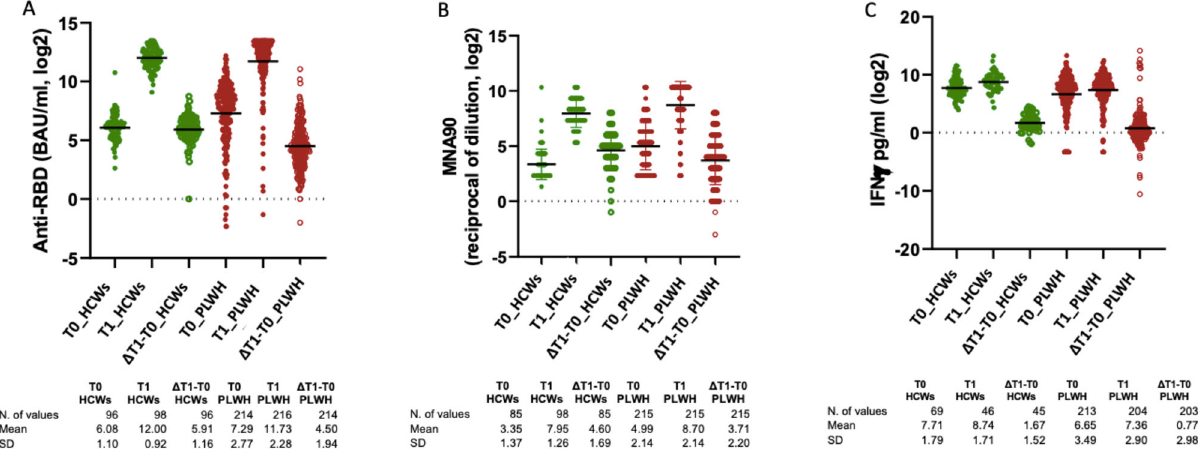
Fig. 3 | Changes of anti-RBD IgG, MNA 90 and IFN- γ from T0 to T1 in HCWs and PLWH. Log 2 change of anti-RBD IgG ( A ), MNA 90 ( B ) and IFN- γ ( C ) from T0 to T1 in HCWs and PLWH; There was evidence for a signi fi cant increase of anti-RBD IgG, nAbs and IFN- γ from T 0 to T 1 ( p <0.0001, p <0.0001 and p =0.0015, respectively);